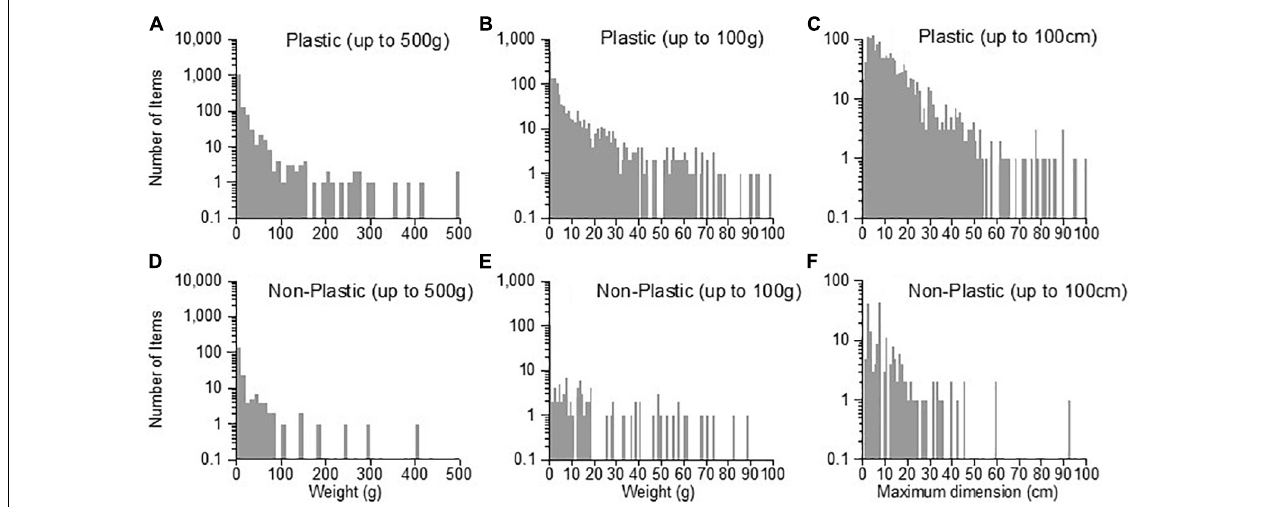
FIGURE 5 | Details of the weight–frequency, and size-frequency distributions of the 1,618 beach litter items collected during 4 quarterly surveys of 10 beach sites in the northeast of Scotland (see Figure 1 ). Note log frequency scale, and that the two mega litter ( > 1,000 g) items have been excluded. Left (A,D) : Frequency of weights of litter items up to 500 g. Bar width = 10 g. Center (B,E) : Frequency of weights of litter items up to 100 g. Bar width = 1 g. Right (C,F) : Frequency of maximum dimensions up to 100 cm. Bar width = 1 cm. The minimum weight able to be recorded was 0.01 g, and the minimum size 0.1 cm.